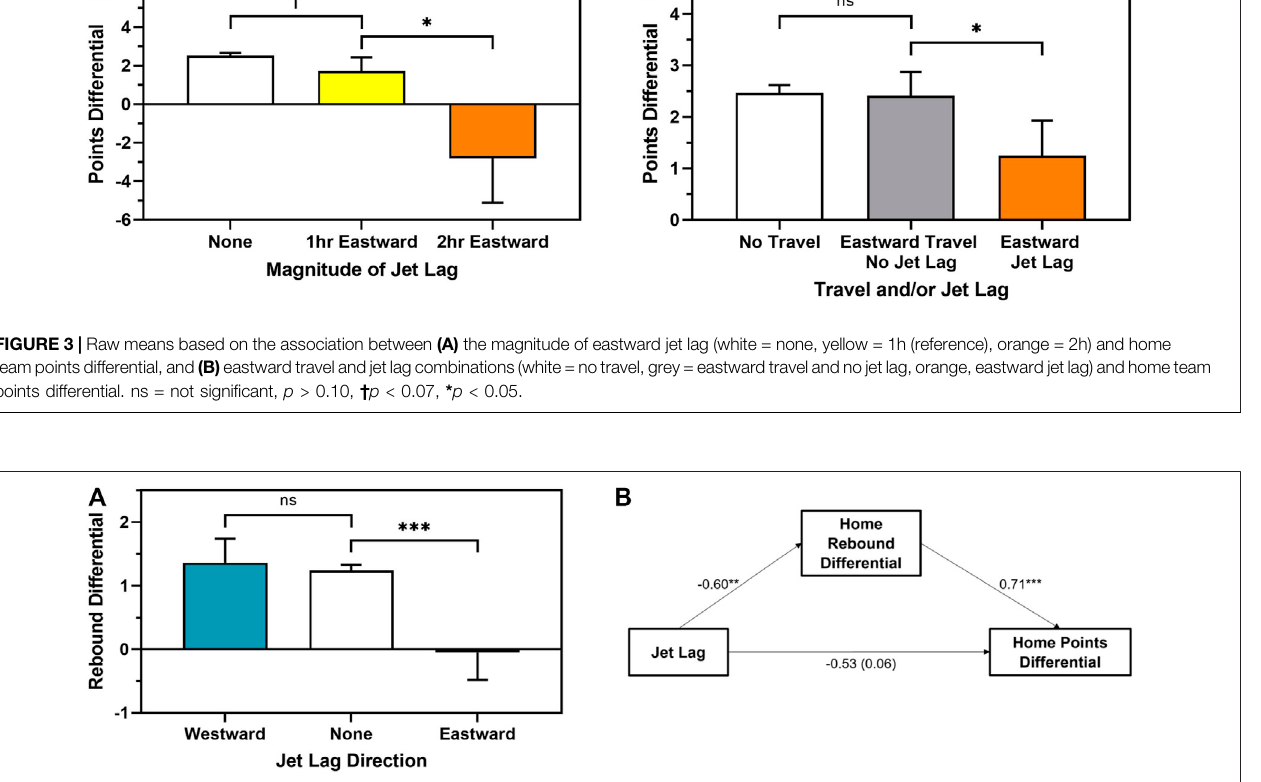
FIGURE 4 | (A) represents raw means based on the association between directional jet lag (blue = westward, white = none (reference), orange = eastward) and home team total rebound differential. (B) represents the mediational model and regression coef fi cients for the relationship between directional jet lag and home points differential as mediated by home rebound differential. The regression coef fi cient between jet lag and home points differential, controlling for home rebound differential, is in parentheses. ns = not signi fi cant , p > 0.10, ** p < 0.01, *** p < 0.001.